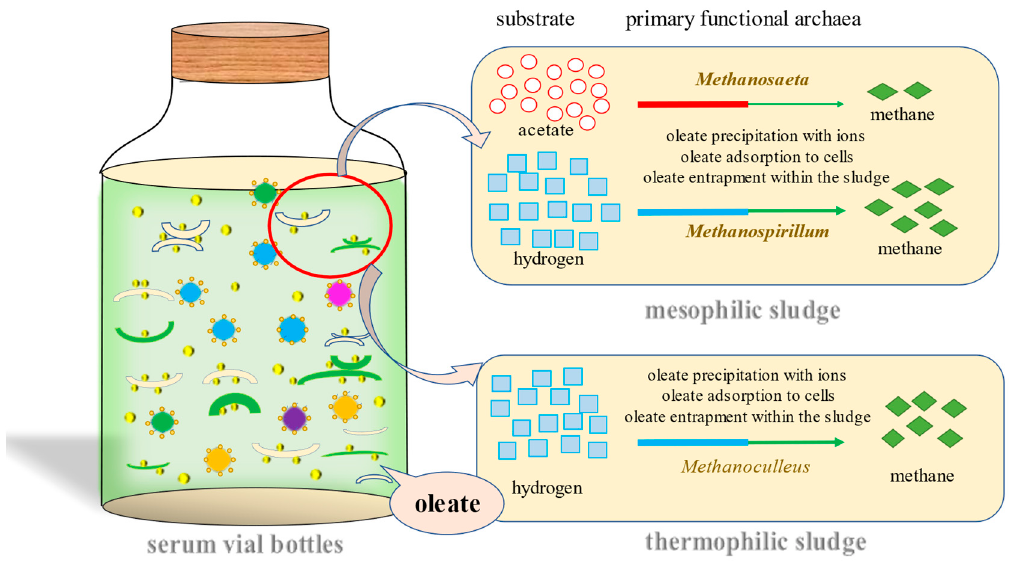
Figure 5. Possible methane conversion pathway impacted by oleate in mesophilic and thermophilic sludge.